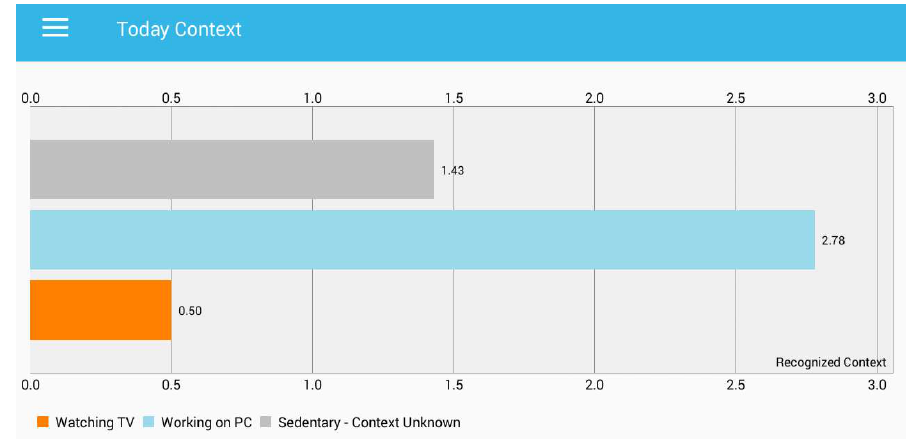
Figure 9. Micro-context